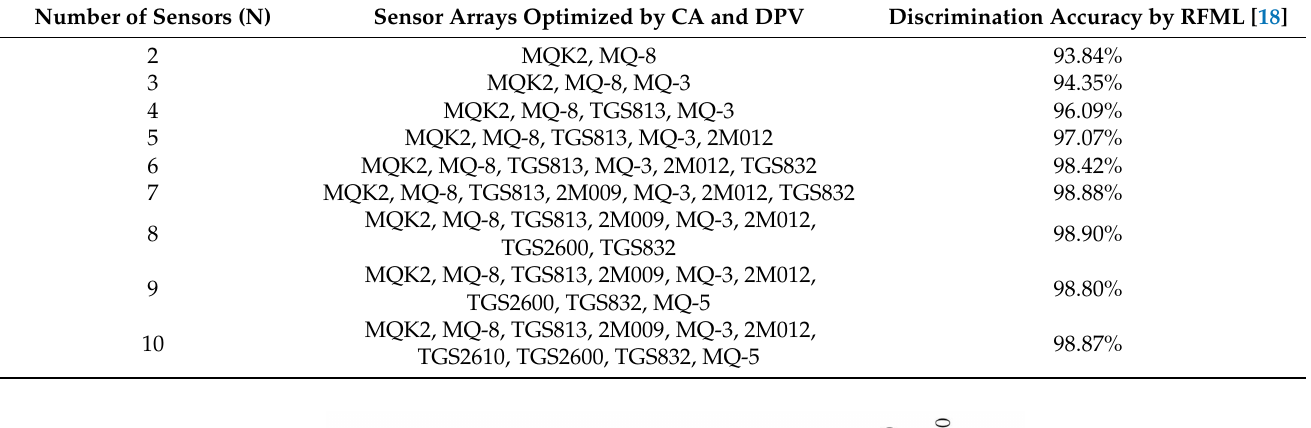
Table 8. Sensor arrays with different numbers N based on CA and DPV.